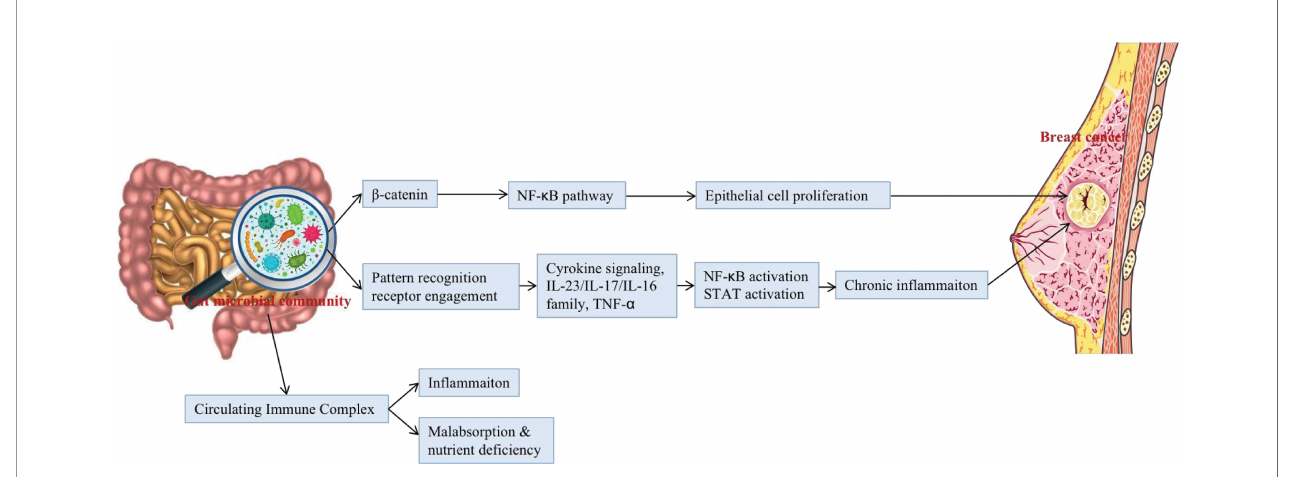
FIGURE 2 | The potential mechanisms that gut microbial community may be associated with the occurrence and development of BC.